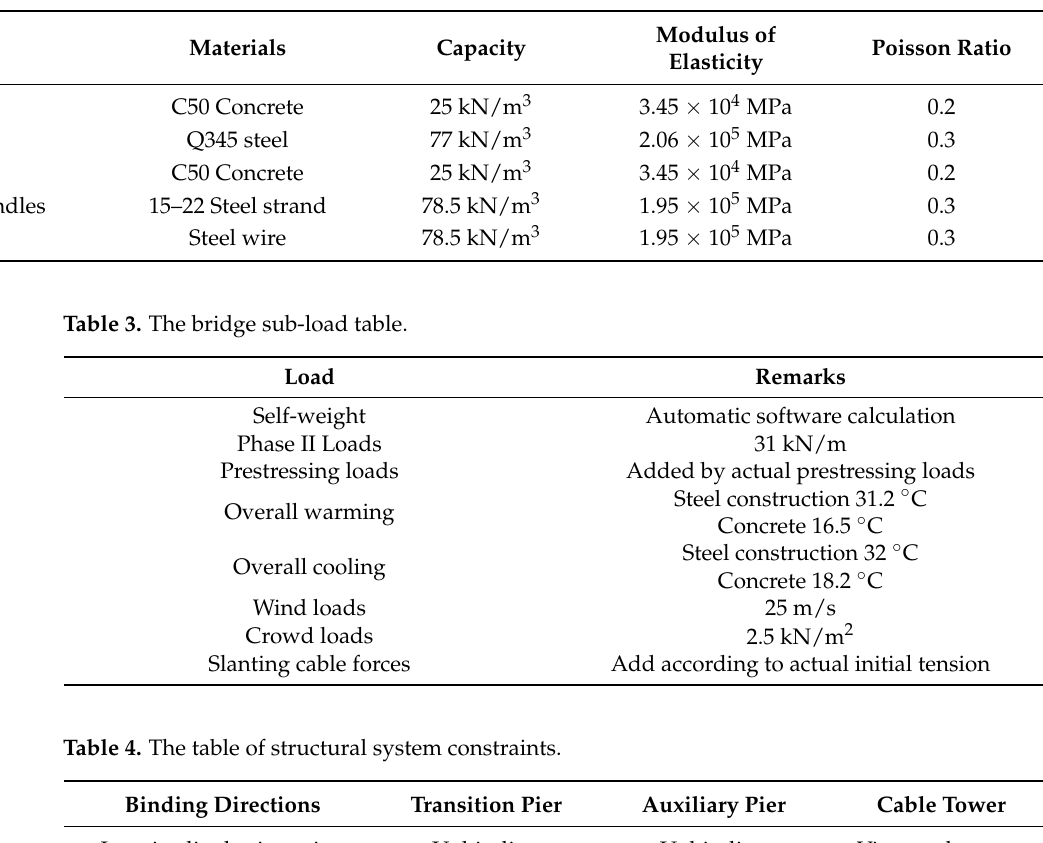
Table 2. The table of initial design parameters for main materials.